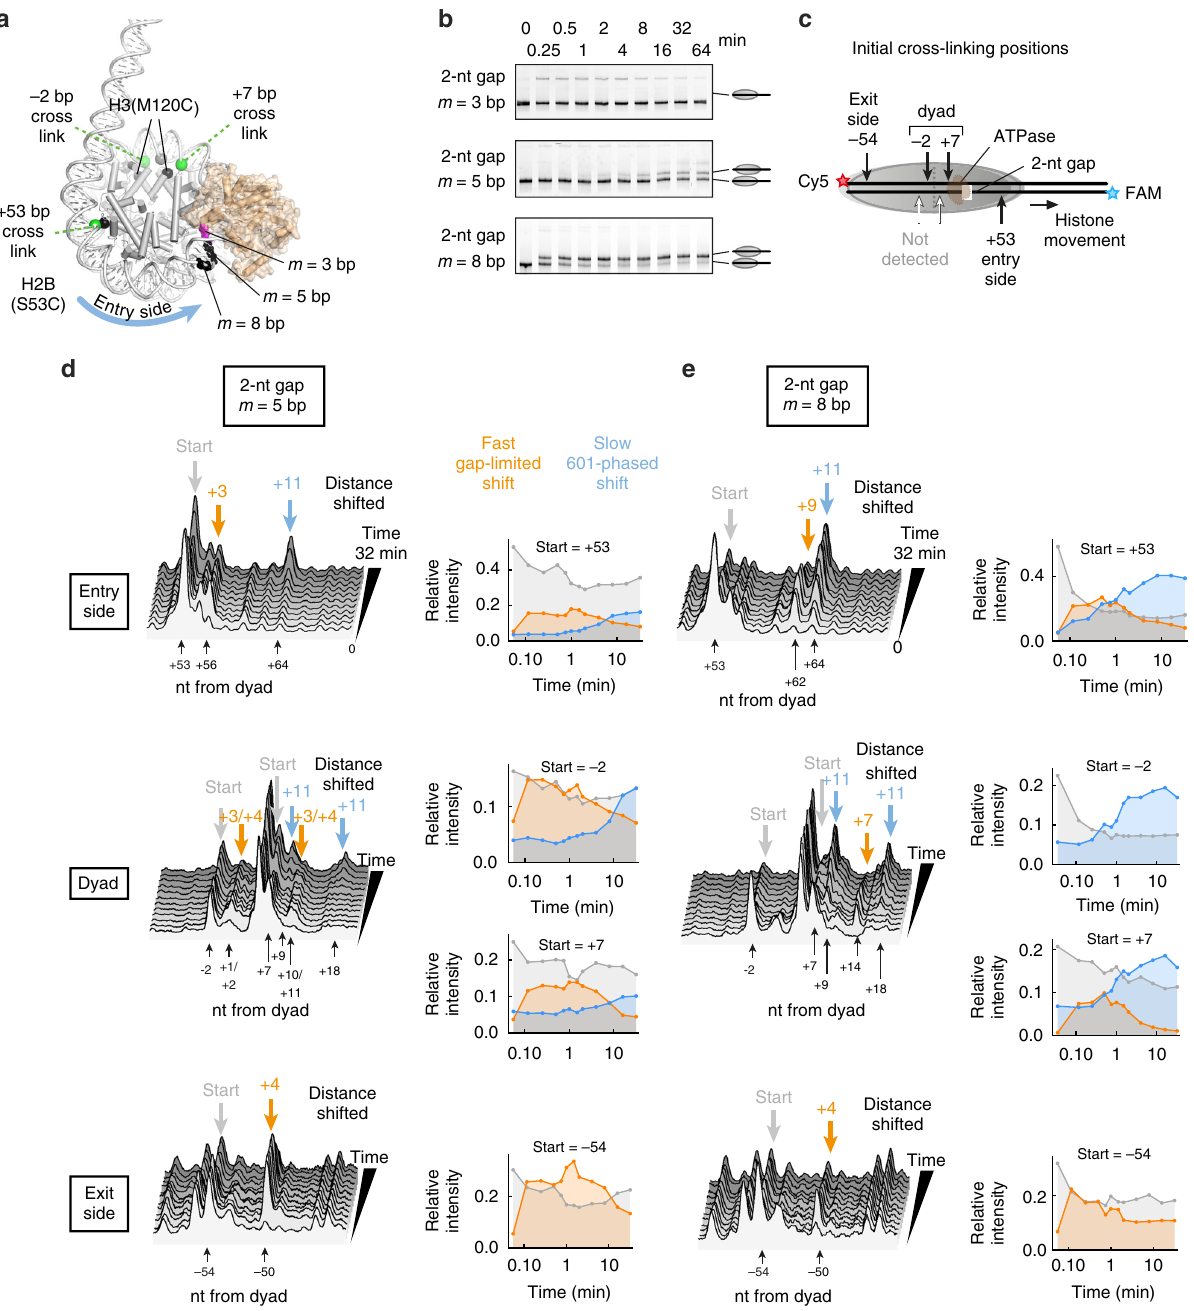
Fig. 3 Buffering 1 to 3 bp is suf fi cient for allowing nucleosome repositioning. a Model of the nucleosome-Chd1 structure (pdb code: 5O9G [ref. 28 .]) showing the position of the ATPase motor (brown) relative to 2 nt ssDNA gaps (black) that limit nucleosome sliding. b Native gel electrophoretic mobility assay comparing sliding of nucleosomes with ssDNA gaps at m = 3, m = 5, or m = 8 nt from the entry-side SHL2. Reactions contained 150 nM nucleosome, 200 nM Chd1 and 1 mM ATP. The supershifted bands at the top of each gel represent Chd1-nucleosome complexes. Gels are representative of two or more independent replicates. c Schematic depicting site-speci fi c cross-linking positions on the nucleosome. Using nucleosomes containing two cysteine substitutions, three regions were simultaneously followed. Nucleosome sliding by Chd1, which shifts the histone core toward the side with longer linker DNA (to the right), can be observed by corresponding shifts of DNA cross-linking sites. d , e Time-course experiments showing Chd1-dependent changes in DNA positioning of nucleosomes containing gaps at m = 5 bp ( d ) and m = 8 bp ( e ). At each cross-linking site, stacked intensity plots showing time- dependent changes in the distribution of cross-links are given on the left, and the relative intensities of starting versus shifted cross-linking products are plotted on the right. Cross-linking products that rapidly appeared and differed depending on the location of the gap are indicated in orange. Products that formed more slowly over time, which correspond to the preferred phase of the 601 sequence, are shown in blue. Note that consistent with previous work 54 , cross-linking on the exit side did not show a nucleosome population shifted by + 11 bp (blue), likely due to sequence bias in cross-linking. Reactions contained 150 nM nucleosome, 200 nM Chd1, and 1 mM ATP. The time-course for these experiments was 0 ” , 7 ” , 15 ” , 30 ” , 45 ” , 60 ” , 90 ” , 2 ’ , 4 ’ , 8 ’ , 16 ’ , and 32 ’ . Results are consistent across three separate experiments, two of which use similar time courses. Gel images are shown in Supplementary Fig. 6. Source data are provided as a Source Data fi